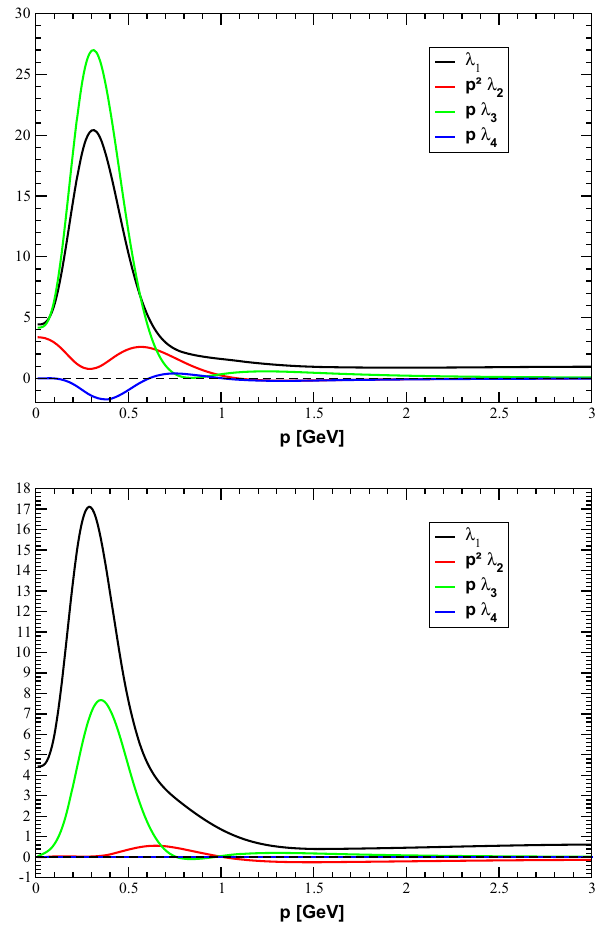
Fig. 42 The form factors for the soft quark kinematical configuration (top) and for the completely symmetric kinematical configuration (bot- tom)